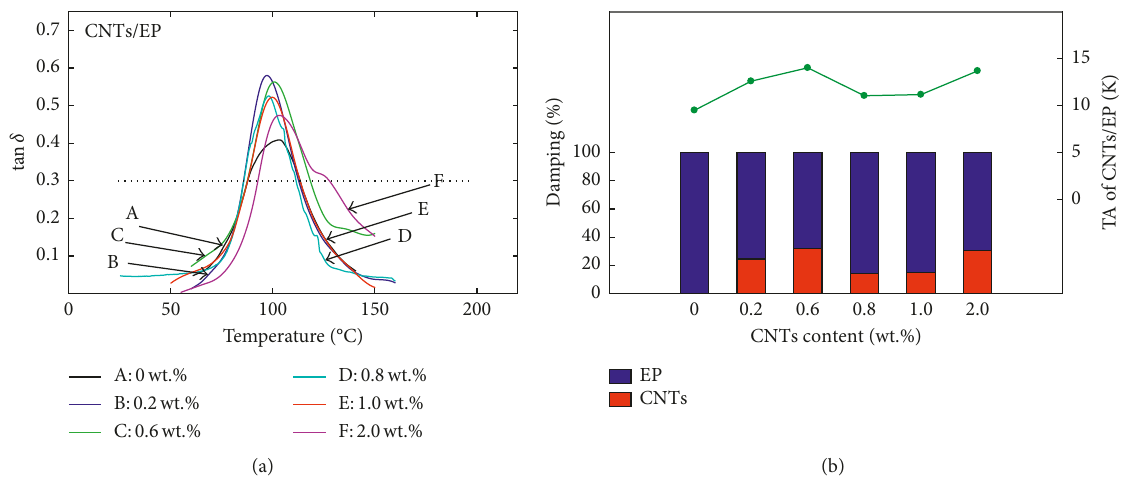
Figure 2: Damping properties of CNTs/EP composites as a function of CNT content: (a) loss factor curves; (b) TA values and damping